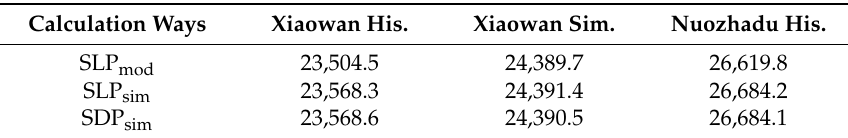
Table 1. Annual energy production in GWh by the SLP model (SLPmod), and by simulation for the SLP (SLPsim) and SDP (SDPsim) without RV